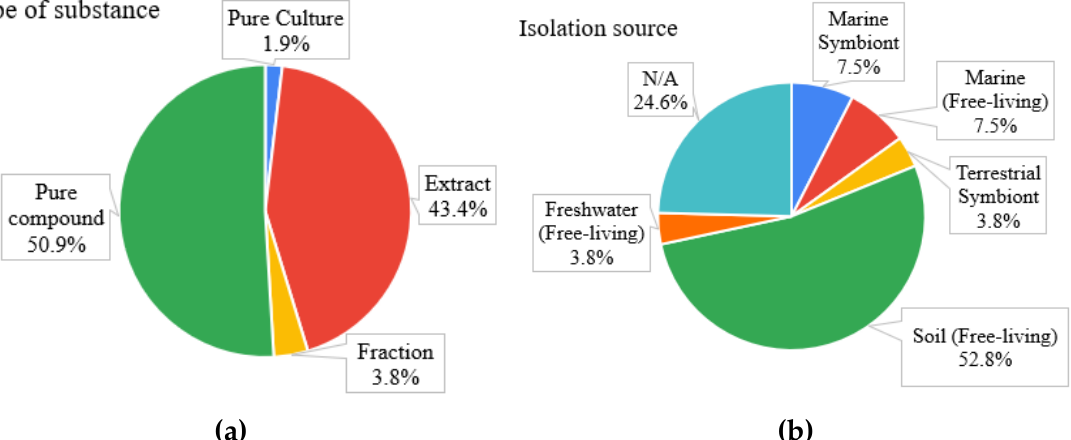
Figure 5. Characteristics of the information registered in the selected articles. ( a ) Percentage of articles that evaluated either crude extracts (see Table S5), pure compounds (see Table S6), fraction, or pure culture. ( b ) Percentage of articles by the environment where the isolation occurred.